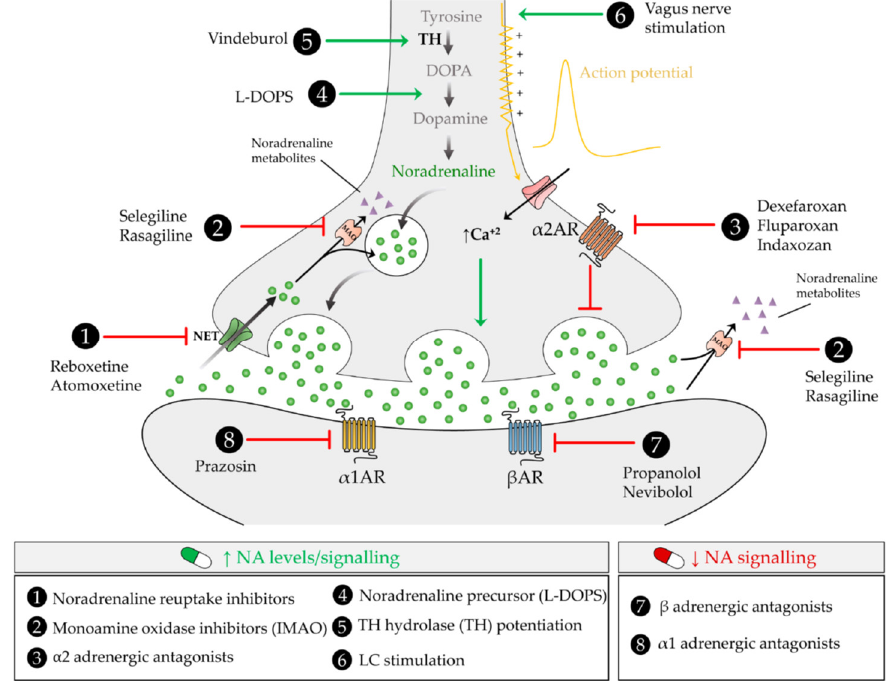
Figure 3. Graphic representation of some of the best known exogenous modulators of brain NA